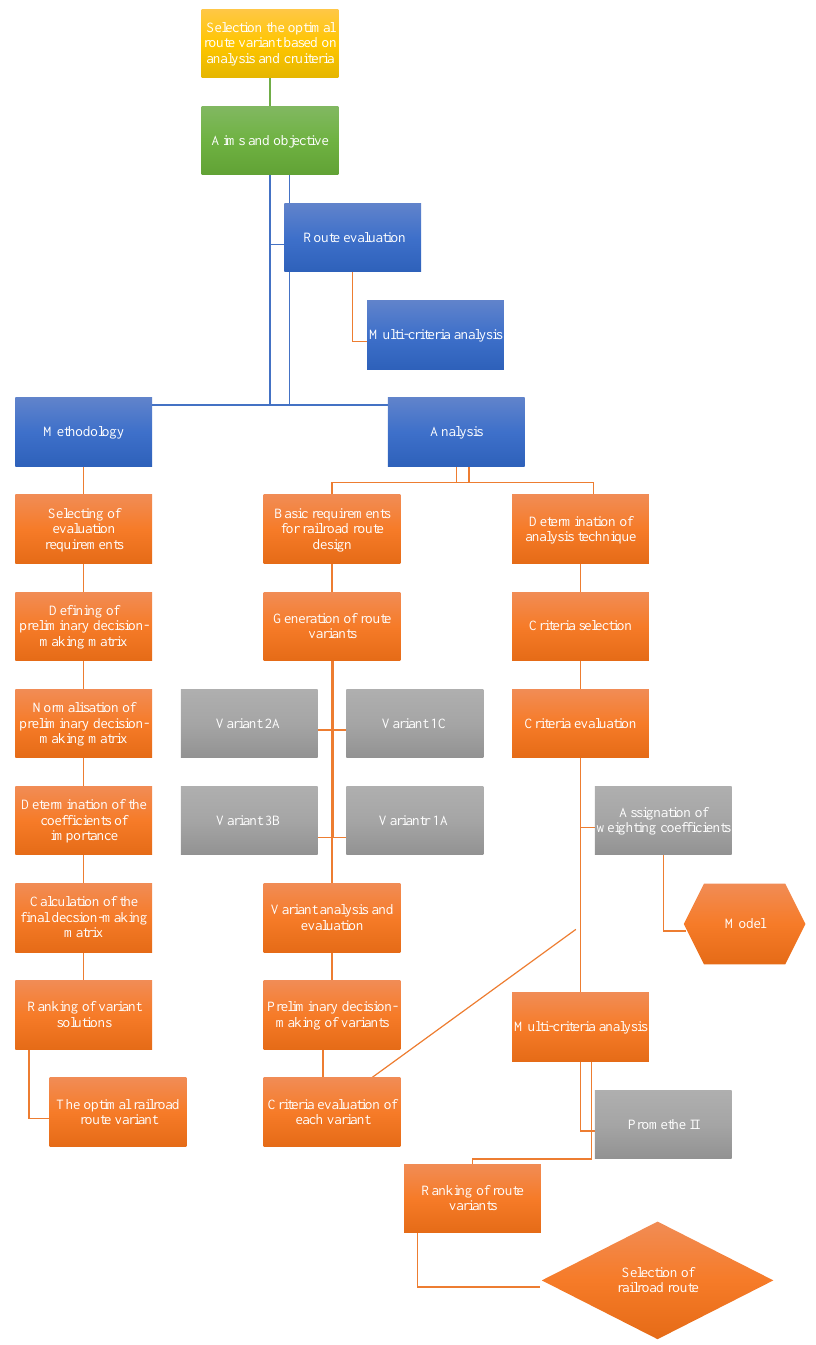
Figure 1. Scheme of decision-making methodology and multi-criteria railroad route evaluation.